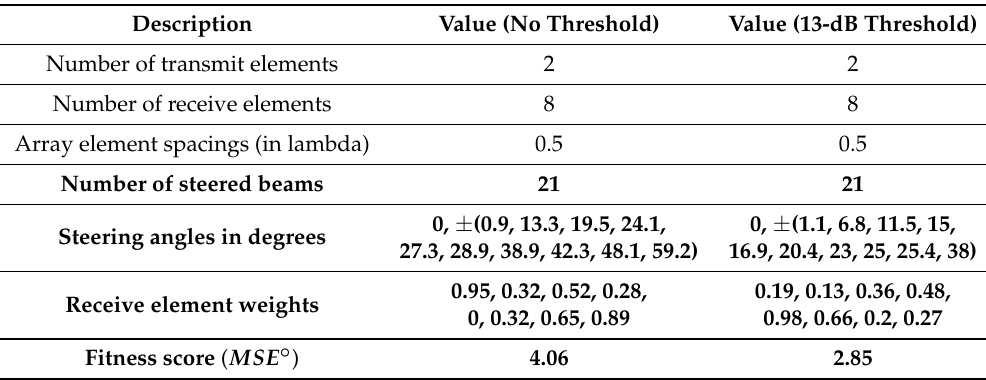
Table 9. Experiment 3